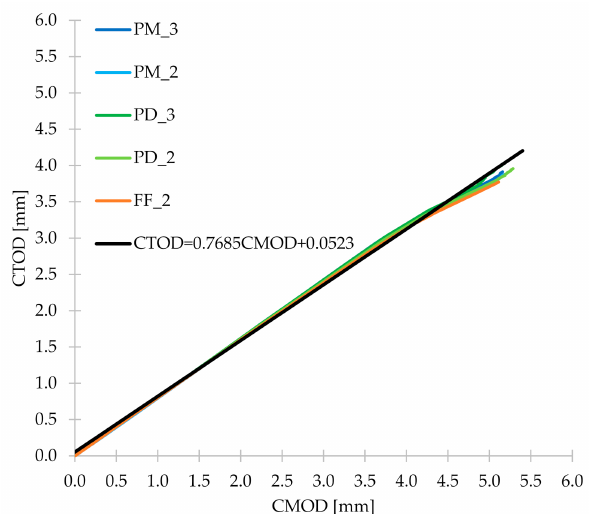
Figure 21. CMOD-CTOD diagram for the tested concrete mixes together with Equation (14) proposed by the